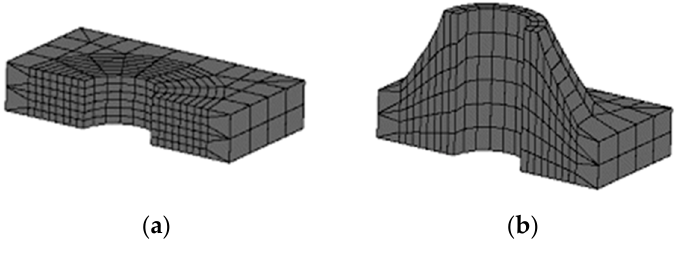
Figure 12. Creation of basis vectors.